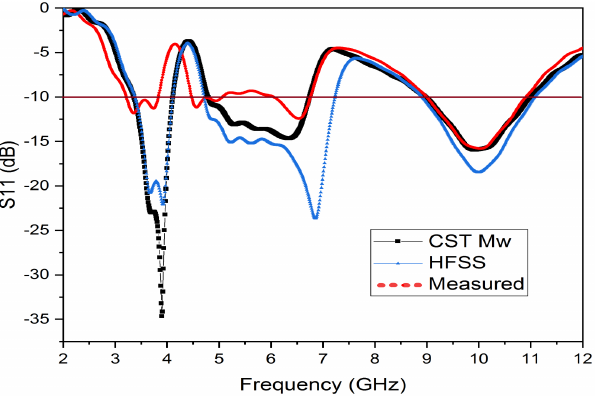
Figure 14. Fabricated model of the proposed antenna (a) front part (b) back part